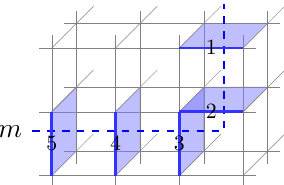
Figure 25. An m -string can be created/annihilated by local operators on the smooth